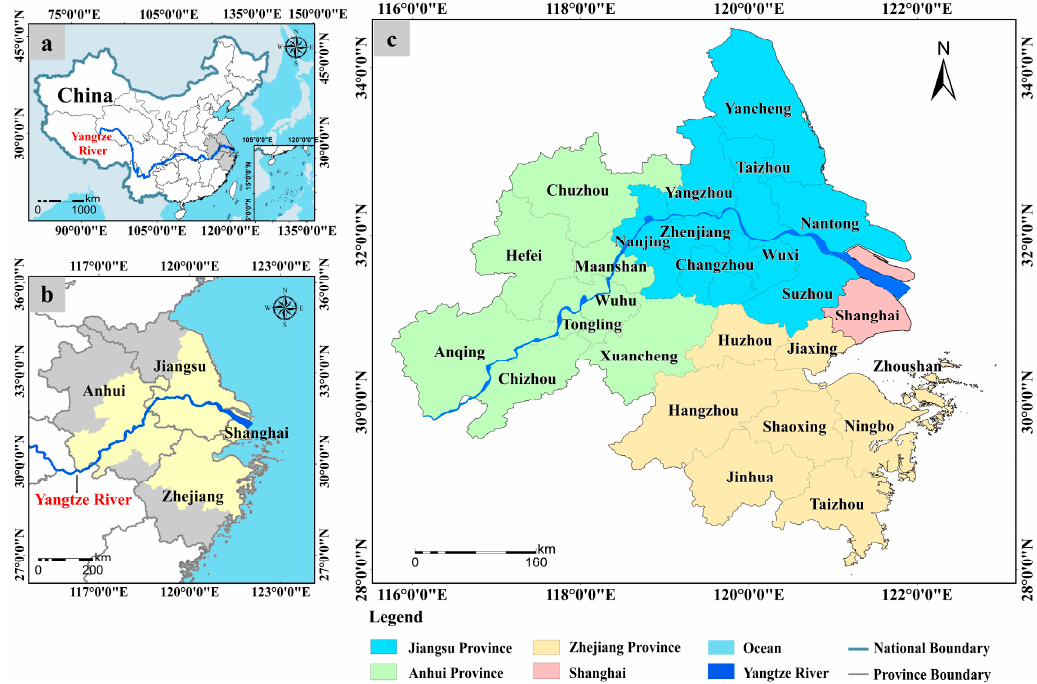
Figure 1. Study area. ( a ) The locations of Jiangsu, Zhejiang, Anhui provinces, Shanghai, and the Yangtze River in China; ( b , c ) the Yangtze River Delta Urban Agglomeration (YRDUA) consisting of 26 cities, eight of Jiangsu, nine of Zhejiang, eight of Anhui provinces, and the municipality of Shanghai.